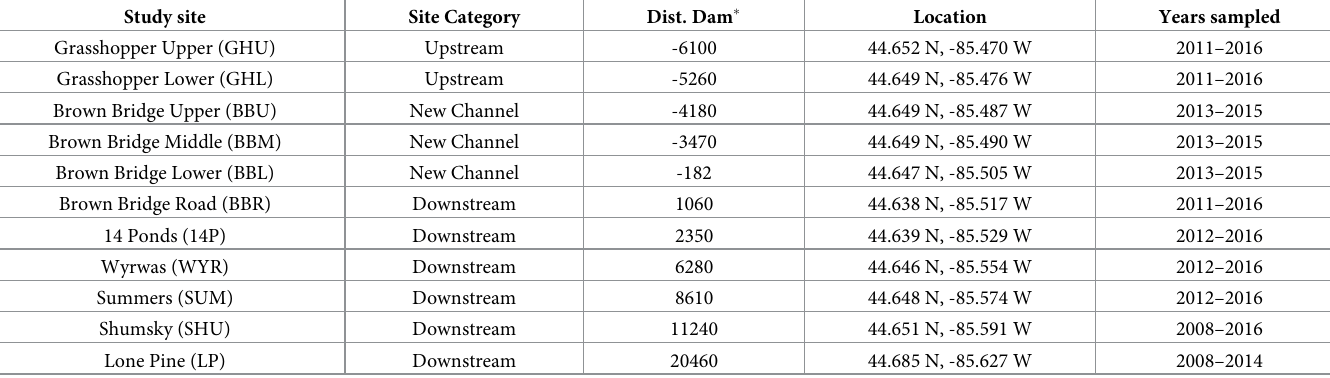
Table 1. Description of study sites in riffle macroinvertebrate survey, 2011–2016, Boardman River, Michigan,